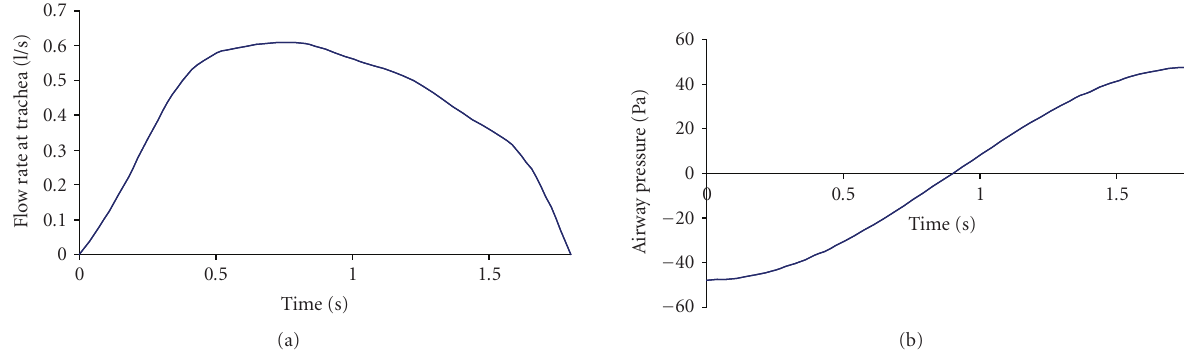
Figure 4: (a) Flow waveform during the normal inhalation at the trachea and (b) the corresponding airway pressure at the airway generation 5.